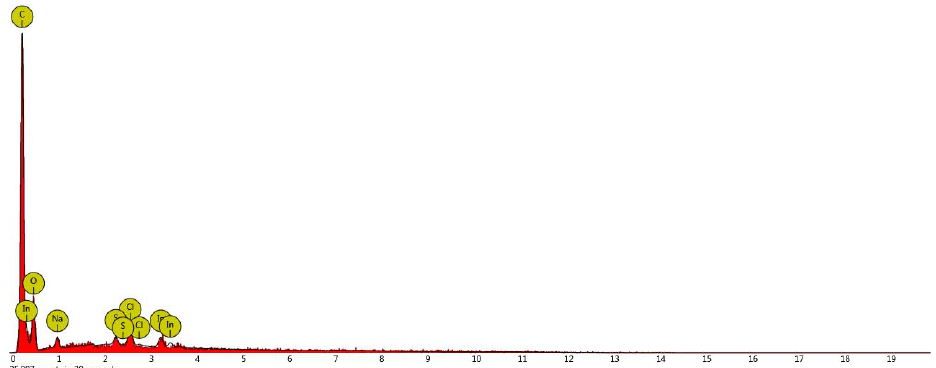
Figure 8. The EDS analysis diagram of the chemical composition of a hybrid-resin specimen taken from the Da 2.x sample, obtained at a 15-keV intensity.